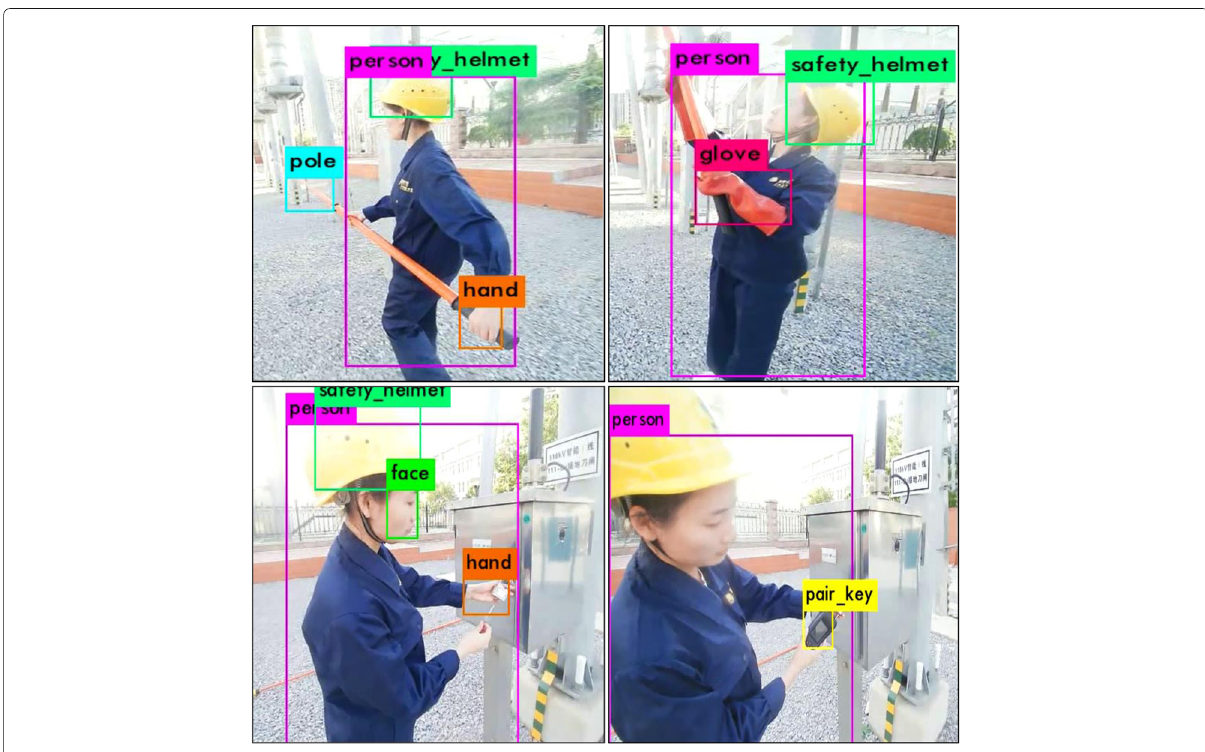
Fig. 11 Object detection